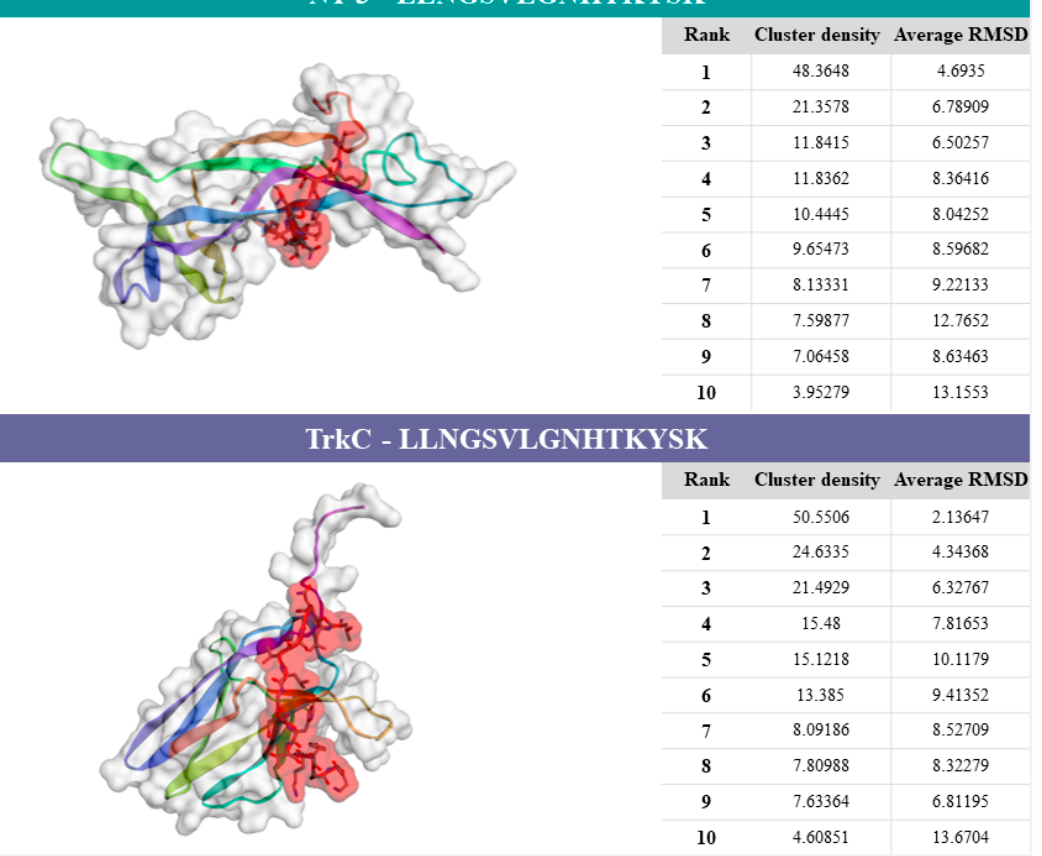
Figure 4. Predictive results of the CABS-dock server. Legend: computational modelling of protein–peptide docking of NT-3 (1nt3:A) or TrkC (1wwc:A) and the peptide sequence (part of the second extracellular loop of NET: LLNGSVLGNHTKYSK). The docking prediction figures of proteins–peptide correspond to model 1. Clustering details of the ten models are shown in the respective tables.